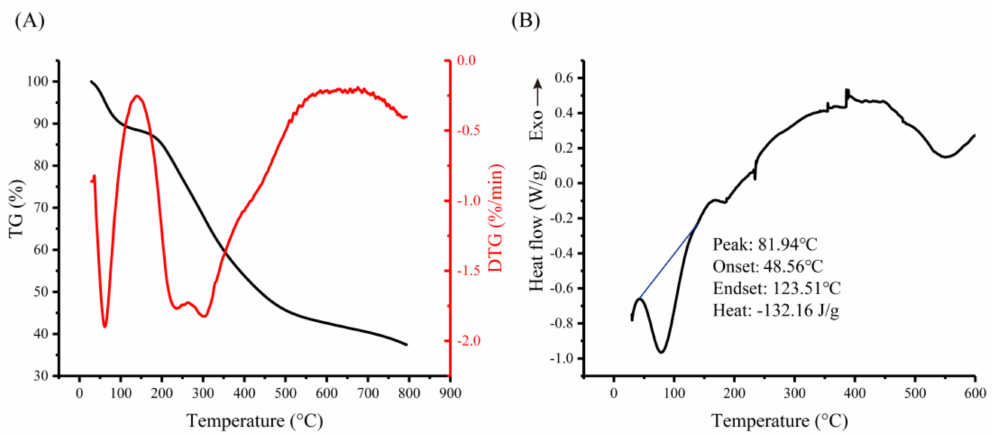
Figure 3. Thermogravimetry / Di ff erential thermogravimetry analysis ( A ) and di ff erential scanning calorimetry ( B ) analysis results of